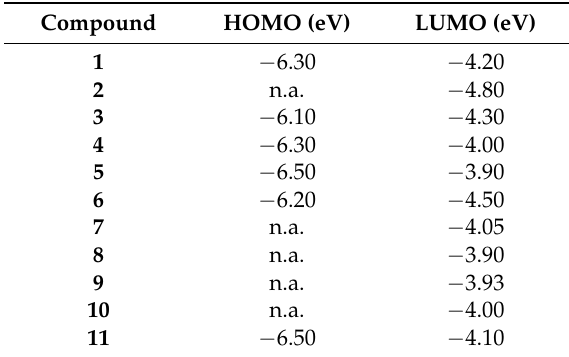
Table 3. HOMO and LUMO levels obtained by the electrochemical measurements. Compound HOMO (eV) LUMO